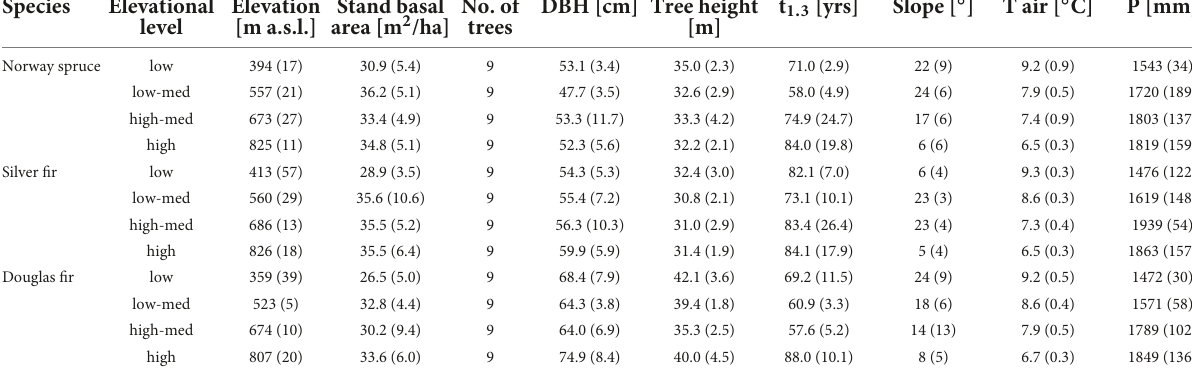
TABLE 1 Sample size and mean values (with standard deviations in parentheses) of elevations, stand basal area, diameter at breast height (DBH), tree height, tree age at breast height (t 1 . 3 ) and slope for all sample trees grouped by species and elevational level.